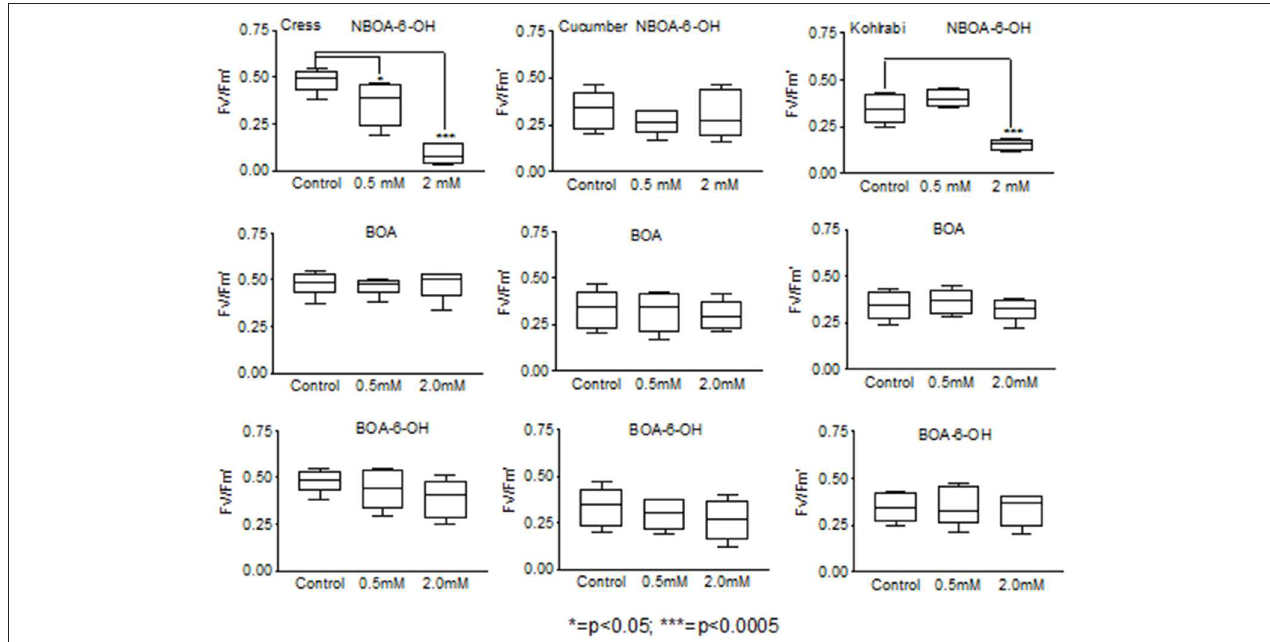
FIGURE 9 | Reduction of the quantum yield by NBOA-6-OH is most pronounced in 3-day-old cress seedlings. p < 0.05; **, p < 0.005; ***, p < 0.0005.